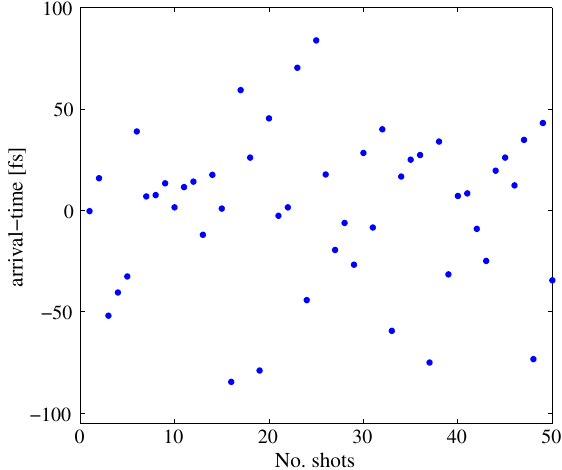
FIG. 8. Spread of the measured arrival time of 50 bunches after the bunch compressor at nominal compression factor. The rms arrival-time jitter for this case is 38